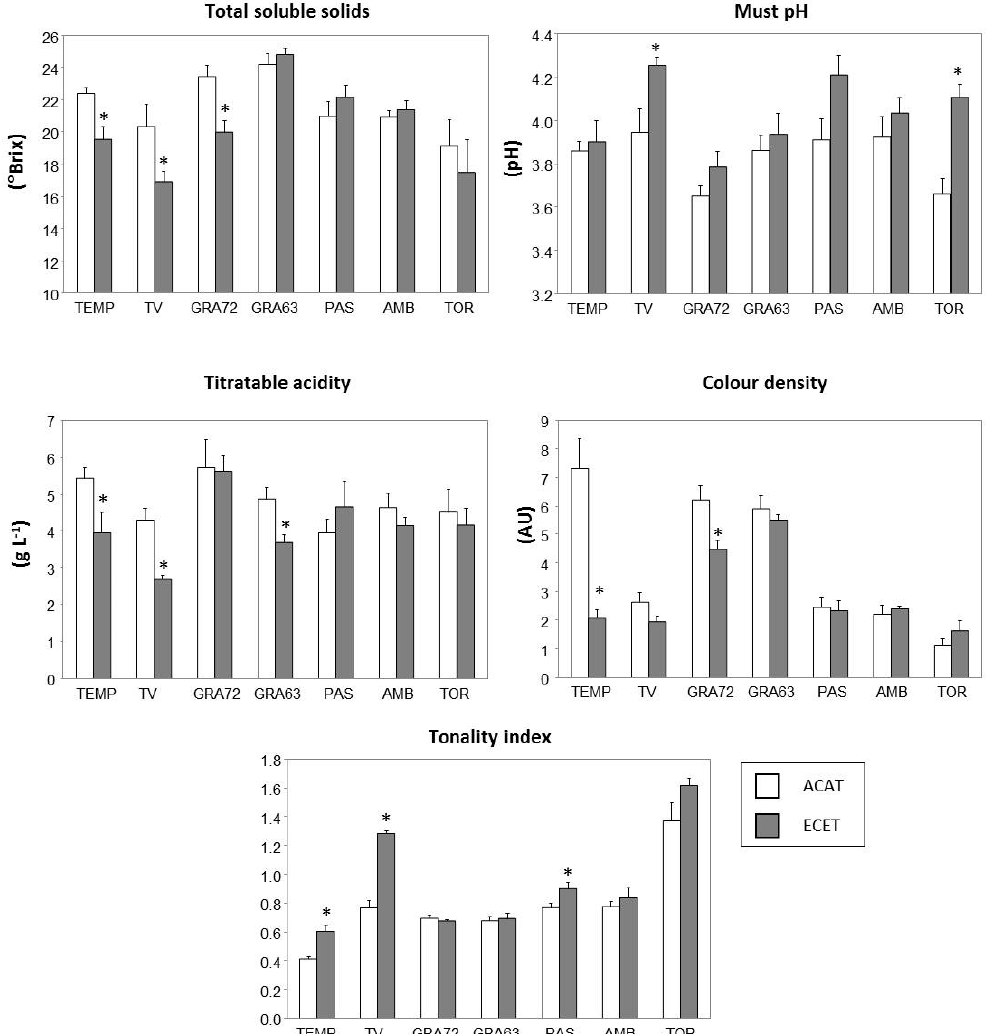
Figure 2. Must characteristics from fruit-bearing cuttings of genotypes from seven local old grapevine varieties recovered in Navarre (Spain) grown under two climate scenarios during berry ripening: (1) ambient CO 2 (400 ppm) and ambient temperature (T) (ACAT) and (2) elevated CO 2 (700 ppm) and elevated temperature (T + 4 °C) (ECET). Values are means ± S.E. (n = 3–6). Within each genotype, asterisks (*) indicate significant differences ( p < 0.05) between treatments according to Duncan’s test. Genotype labels can be found in Table 5.